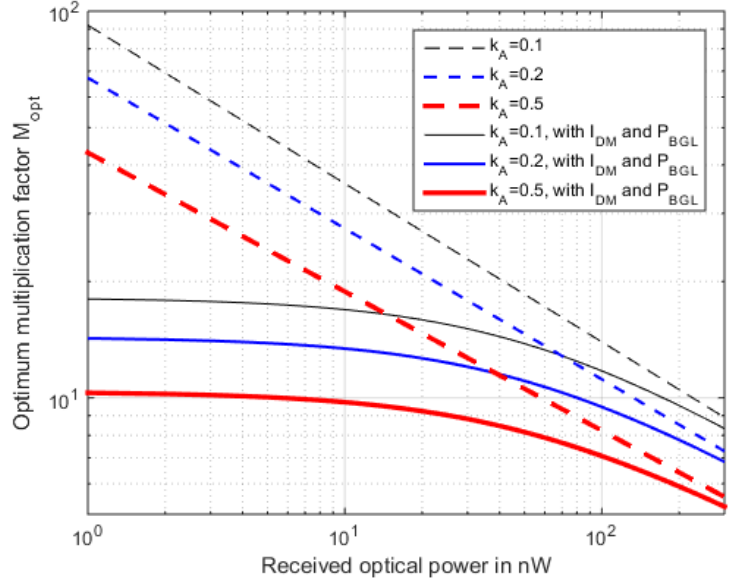
Figure 3. Optimum multiplication factor M opt with CW illumination, for different k A , without and with I dm = 2.5 nA and P BGL = 50 nW. Dependency of M from Bias Voltage and Temperature